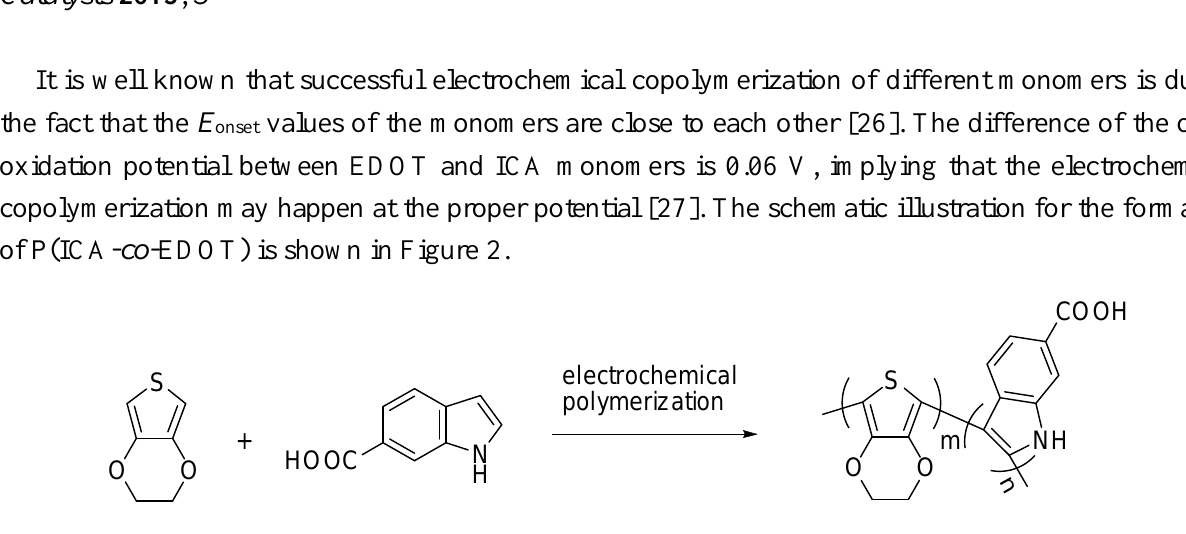
Figure 2. Schematic illustration for the formation of P(ICA- co -EDOT).